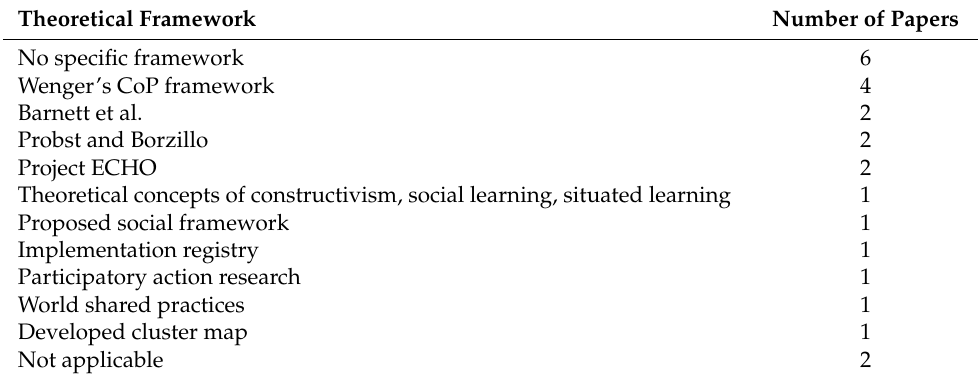
Table 5. Theoretical framework for development of